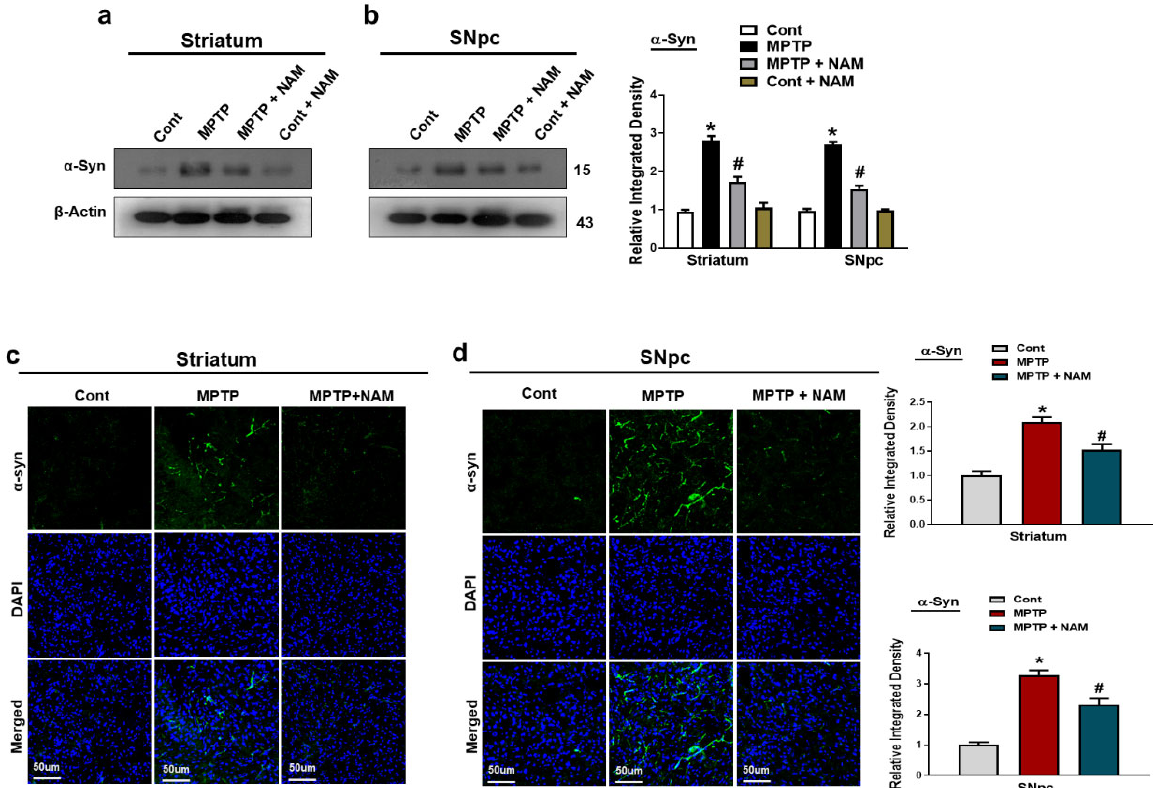
Figure 3. Nicotinamide (NAM) abrogated the α -synuclein level in the Striatum and SNpc of the mouse brain. ( a , b ) Western blot analysis of α -synuclein, in the striatum and SNpc of different experimental animals; ( c , d ) Immunofluorescence analysis of α -synuclein, (green) and its corresponding histogram and dapi staining (blue) in the striatum and SNpc regions. The densities values are expressed in arbitrary units (AU), magnification 10 × , scale bar = 50 µ m. The values are expressed as the mean ± SD for indicated proteins ( n = 10 mice/group), and the number of independent experiments was n = 3. * Significantly different from the control group; # Significantly different from the MPTP-treated group. Significance: * p < 0.05; # p < 0.05.